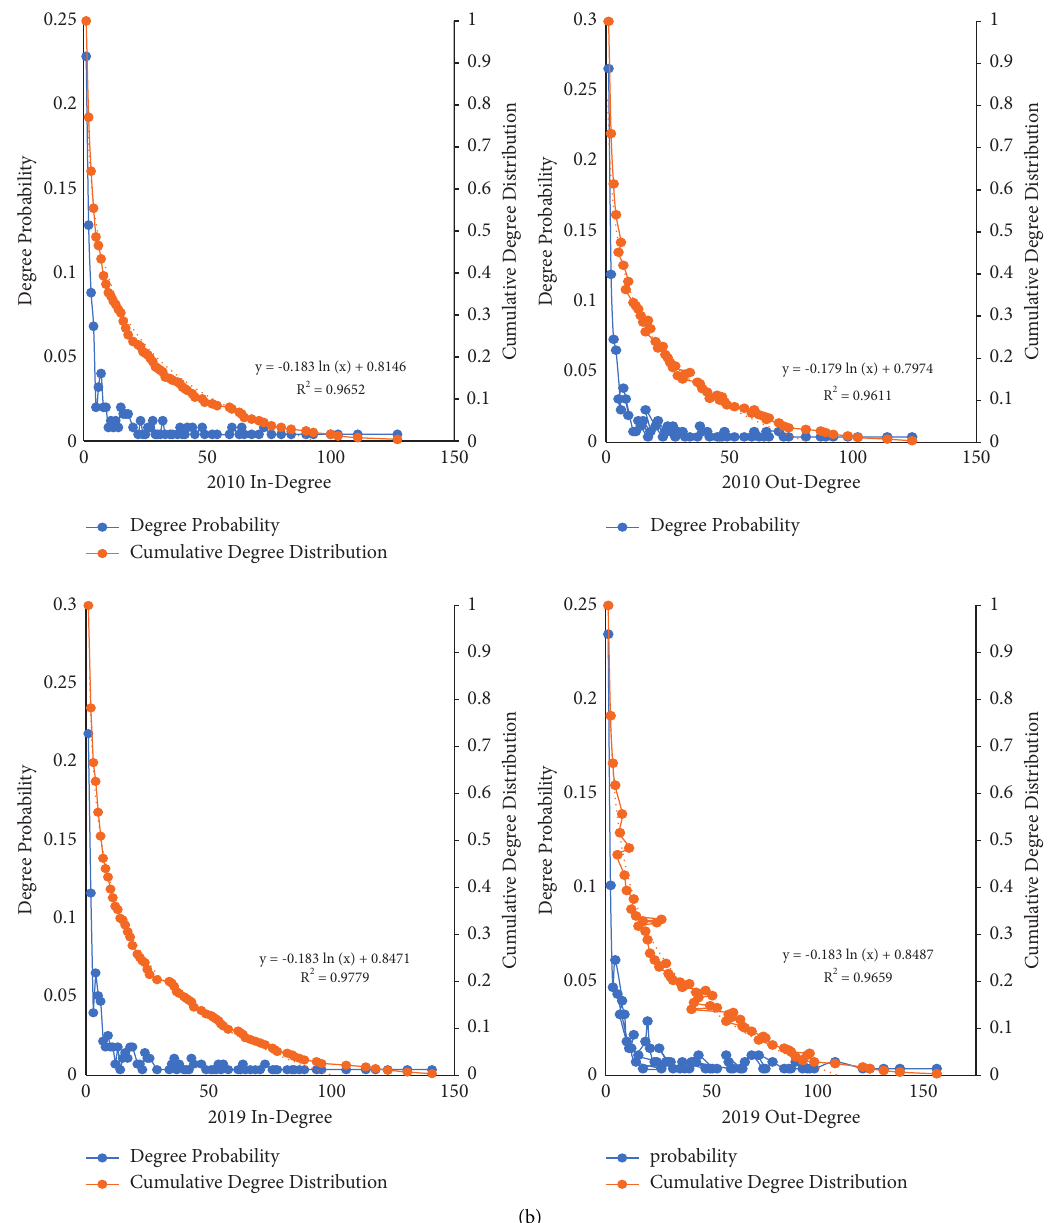
Figure 1: Evolution of cumulative in-degree and out-degree of the USACN from 1990 to